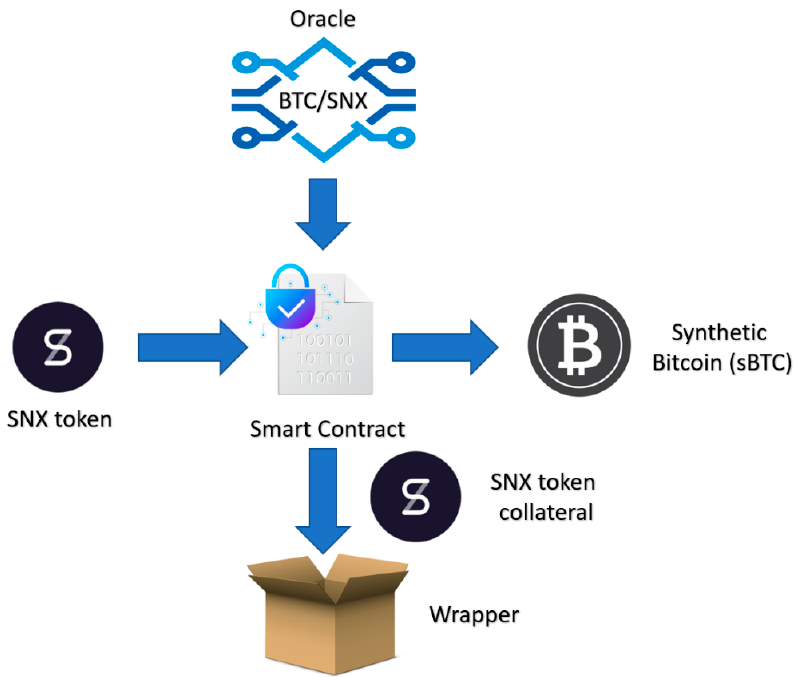
Figure 5. Synthetic BTC minting.